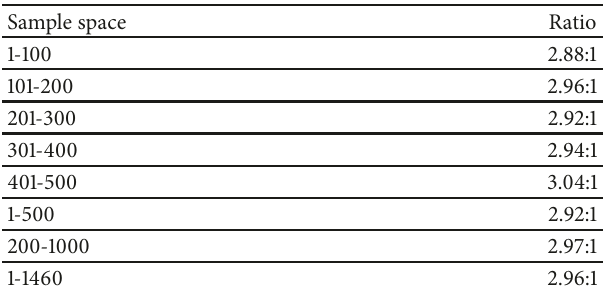
Table 4: Selective RF ratios of the Collatz even elements samples. Sample